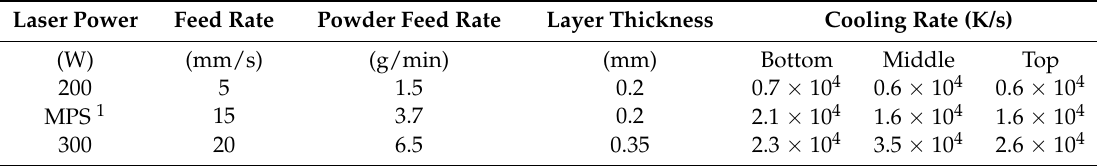
Table 1. Manufacturing parameters of LENS samples and obtained sample cooling rates. Laser